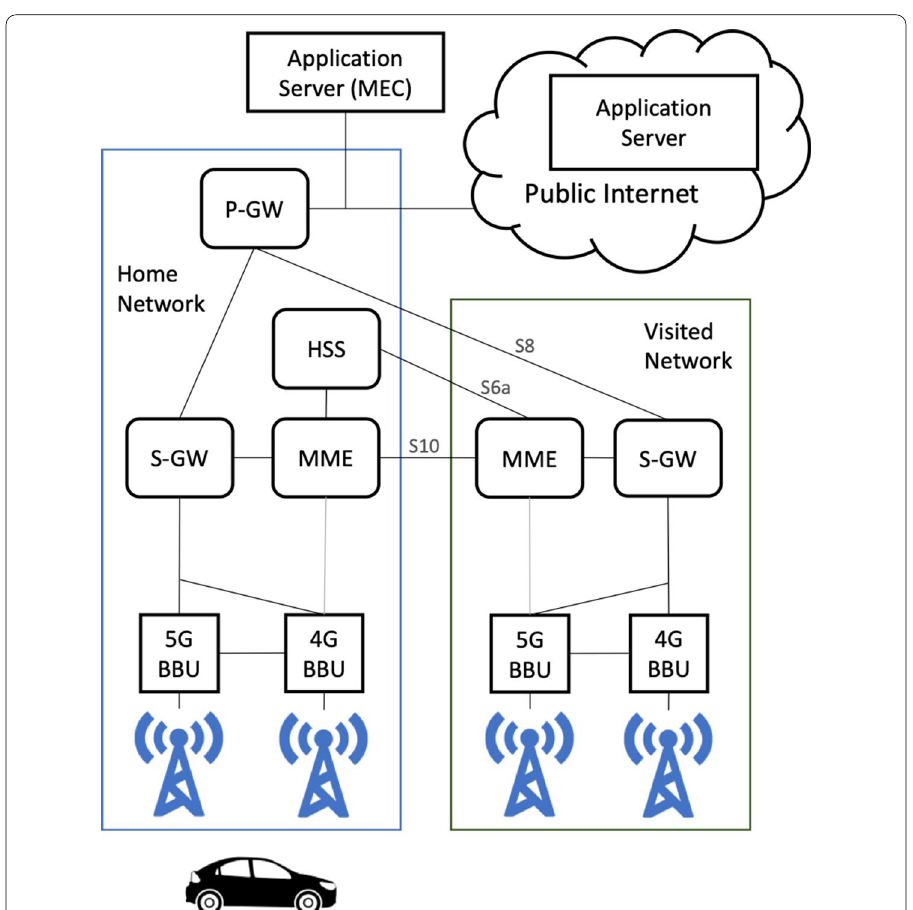
Fig. 4 High level architecture deployed for 5GCroCo